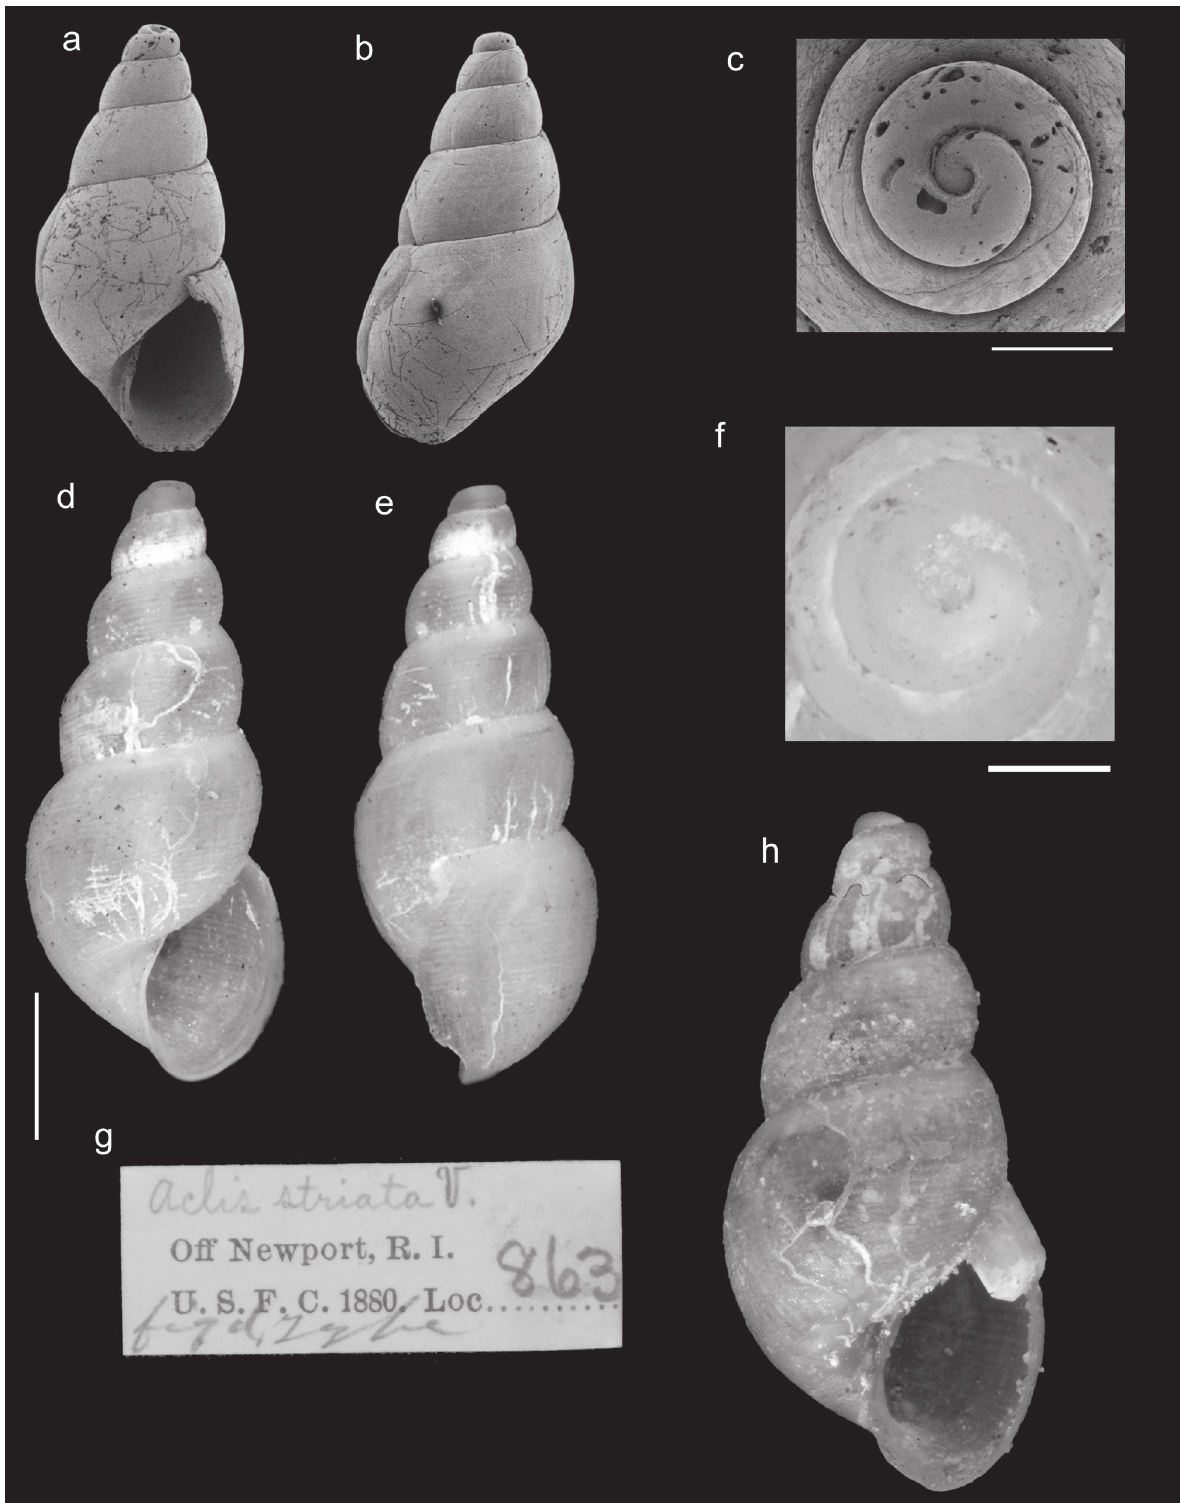
Figure 2. A. Shell of Odostomia ( Evalea ) ryclea , holotype (USNM 108365) in ventral view; B. same, in adapertural view; C . same, detail of protoconch in apical view. D. Shell of Ondina striata , paralectotype (USNM 44820), in apertural view; E. same, in ada- pertural view; F. same, detail of protoconch in apical view. G. Original label of USNM 44820, showing a hand-written indication of “figd. type” by A. E. Verrill.; H. Ondina striata , a non-type shell (YPM 15704) erroneously indicated as lectotype by Johnson (1989). Scale bars: whole shells (vertical bar): 1 mm; detail (horizontal bar): 200